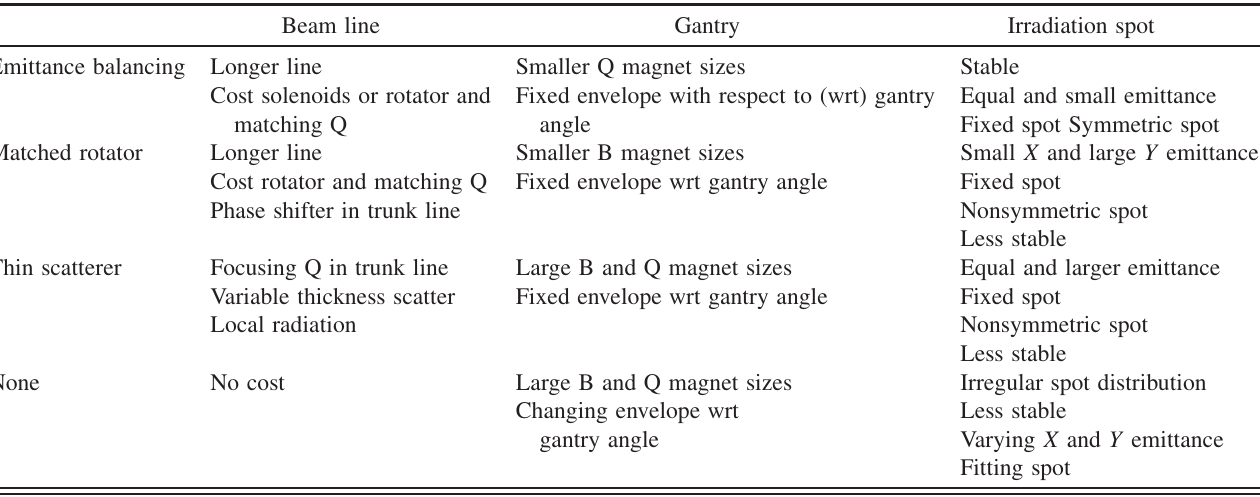
TABLE II. Comparison among different matching methods to gantries, where the beam has a large difference between the two transverse emittances. Q denotes quadrupole magnets and B bending magnets.